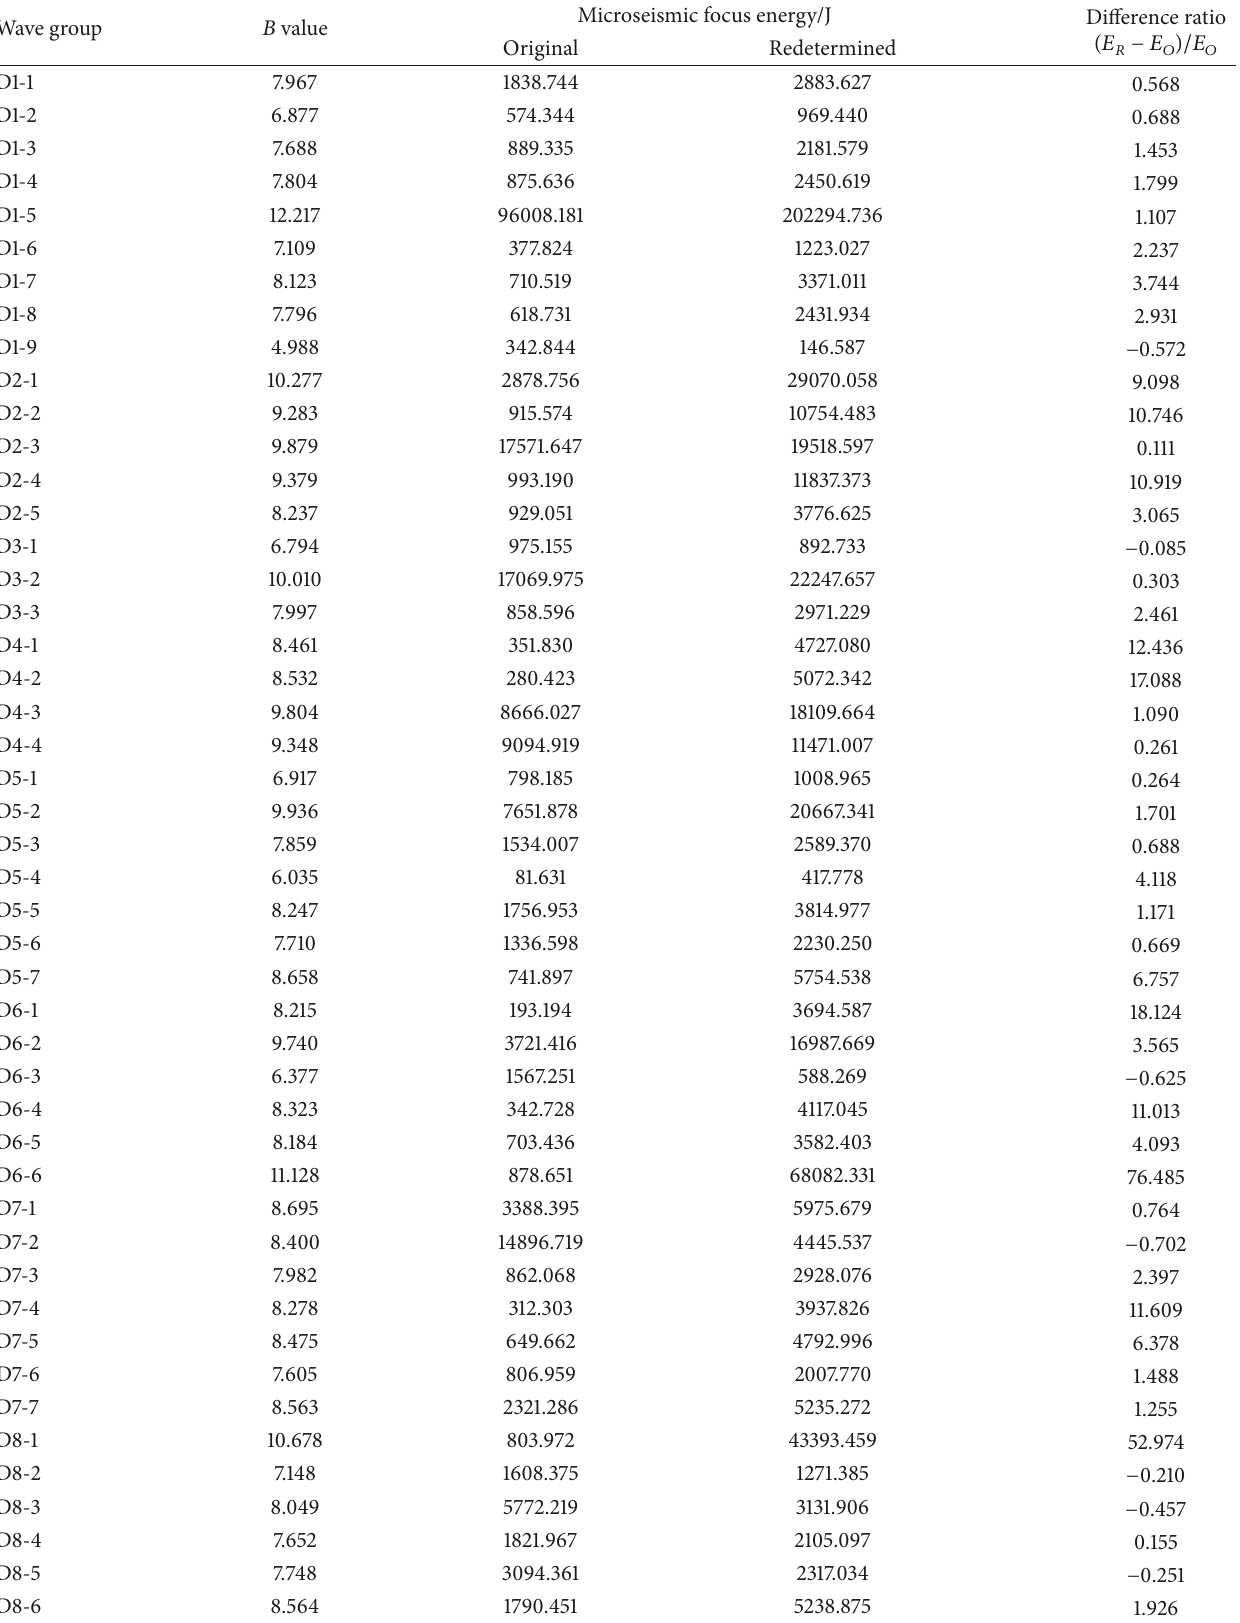
Table 2: 𝐵 value and redetermined magnitude of the microseismic focus energy comparison. Wave